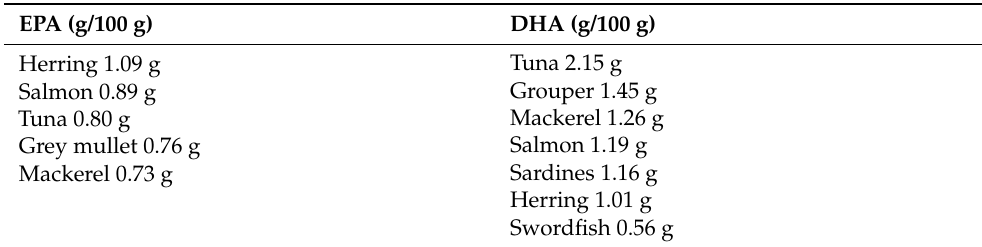
Table 1. Eicosapentaenoic acid (EPA) and docosahexaenoic acid (DHA) content in different fish species [13].